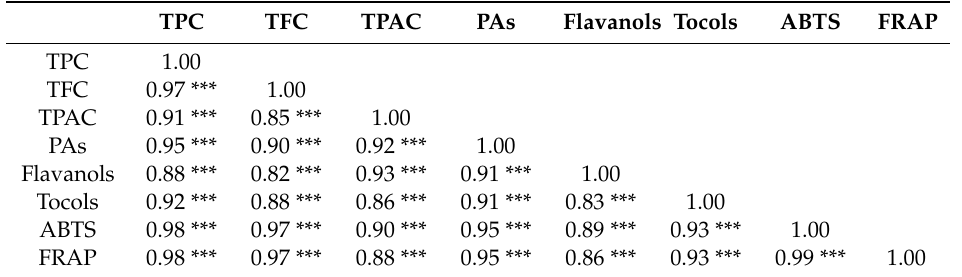
Table 5. Correlation coe ffi cients among phytochemical components and antioxidant activity of barley cultivars. TPC TFC TPAC PAs Flavanols Tocols ABTS FRAP TPC 1.00